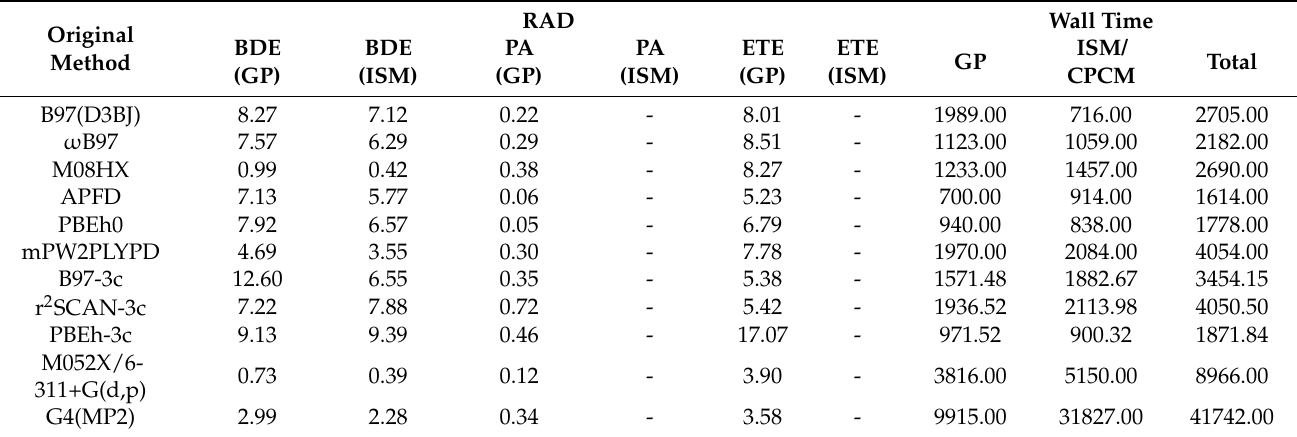
Table 2. Relative absolute deviations (RADs) for all original methods (in %) and their total wall times (in